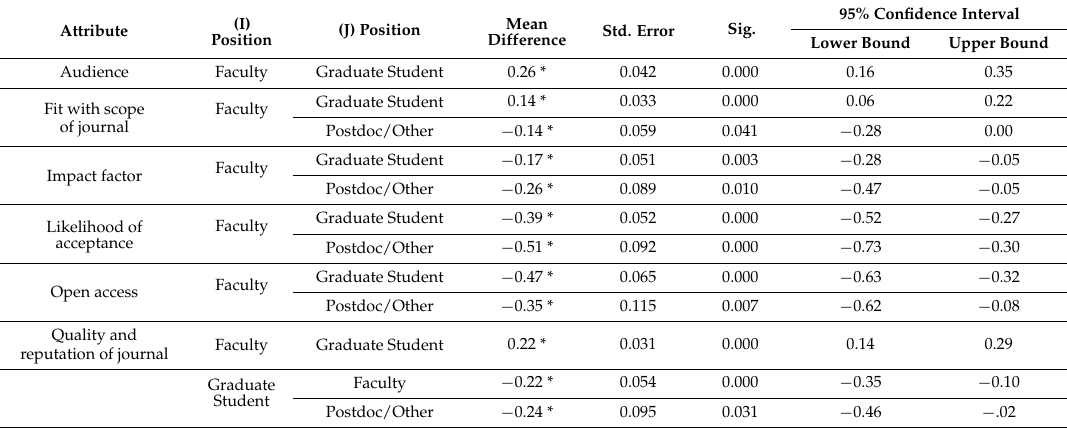
Table 5. Multiple comparisons, journal attribute by position type (Tukey HSD) *.